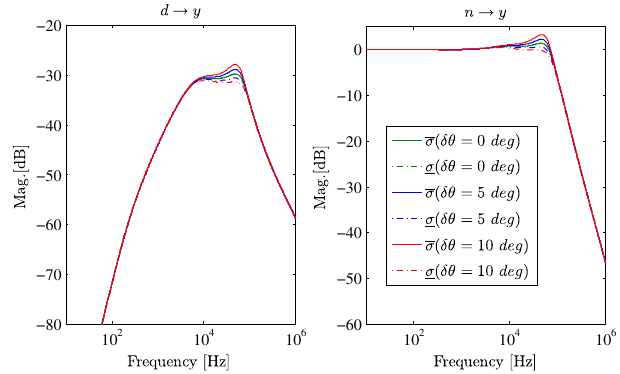
FIG. 11. The singular value of the closed-loop transfer function matrix from d and n to y in terms of different phase calibration error δθ (see Fig. 4). The ¯ σ in each transfer function indicates their H ∞ norm.